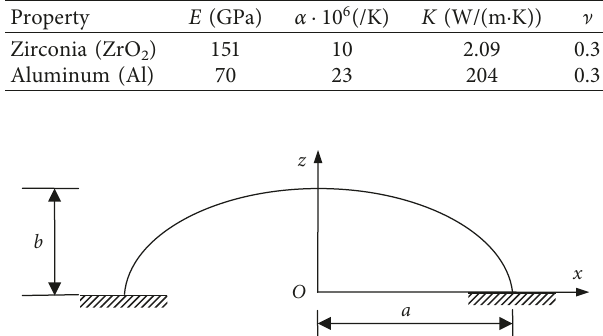
Figure 2: Configuration of the semielliptic curved beam with two ends